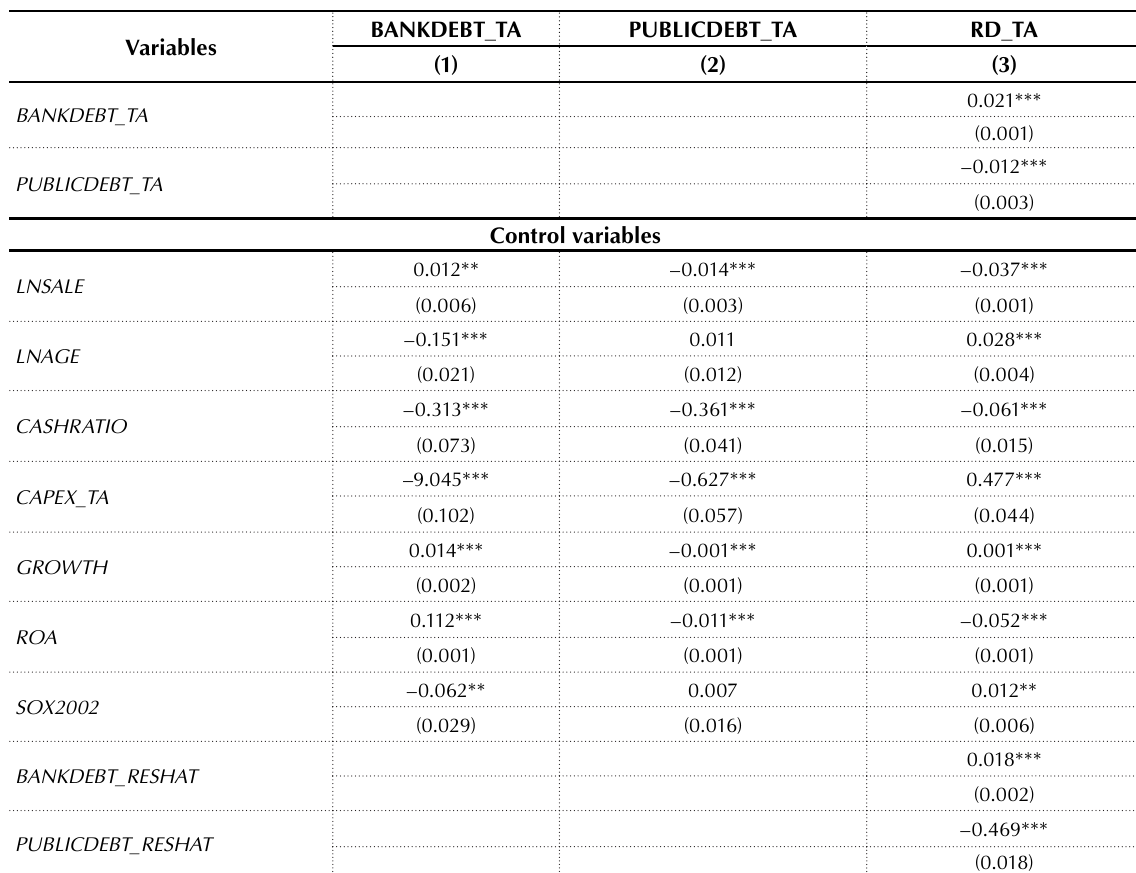
Table 2. Hausman test for